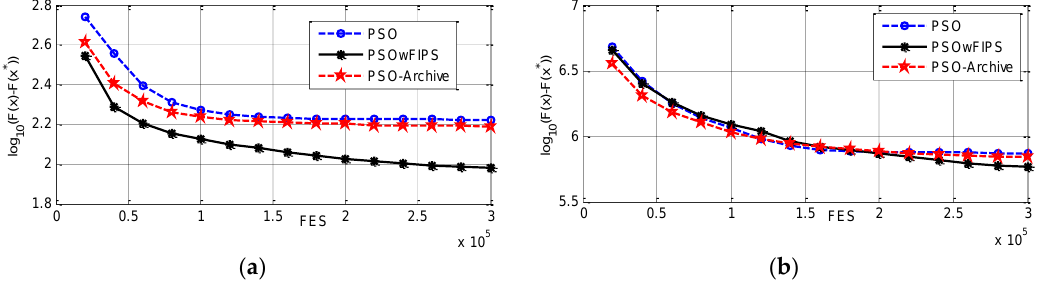
Figure 1. The mean function error values versus the number of FES on test problems. ( a ) f 4 ; ( b ) f 17 .